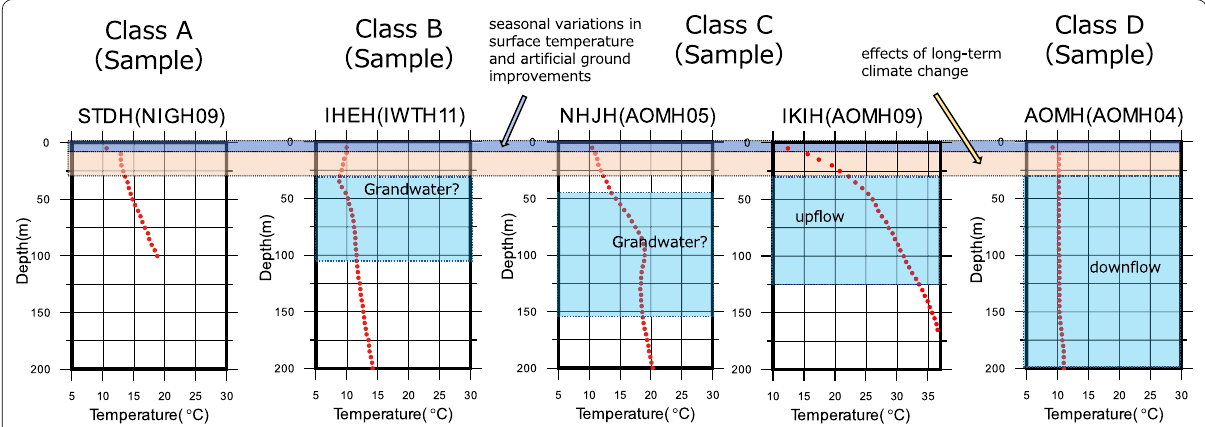
Fig. 3 Example of well temperature logging data quality. The blue section in the background (0–10 m depth) is affected by seasonal variations in surface temperature, artificial ground modification, and soil cut and fill and is excluded from the evaluation. The section in the beige background (10–30 m depth) is excluded from the evaluation because it is mainly affected by the temperature increase over the past 100 years. Sections that may be affected by groundwater are shown with a sky-blue background. Class-A data are considered high data quality, while Class-D data are considered unsuitable for heat flow